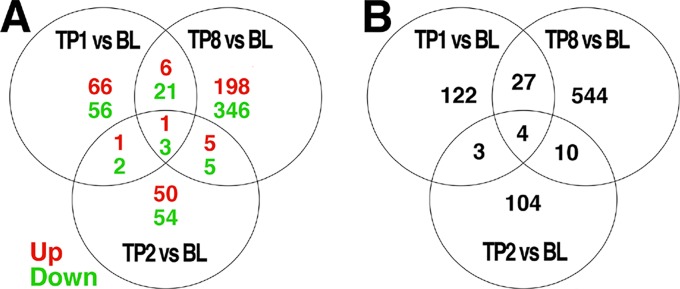
Venn diagrams of genes differentially expressed over time, and the intersection of genes between each comparison. Differential expression analyses were conducted to compare expression levels within patients and between the indicated timepoints: BL = baseline, TP1 = week 1, TP2 = week 2, TP8 = week 8 after pharmacotherapy; e.g., TP1vs BL indicates those genes differentially expressed between TP1 as compared to BL. The number of genes differentially expressed at a threshold of p < 0.005 between each pair of time points are indicated. Those genes showing a change in expression across multiple comparisons are indicated in the intersections of each diagram. In (A), the number of genes showing increased expression is indicated in red, while the number of genes showing decreased expression is indicated in green. The total number of differentially expressed genes is shown in (B).